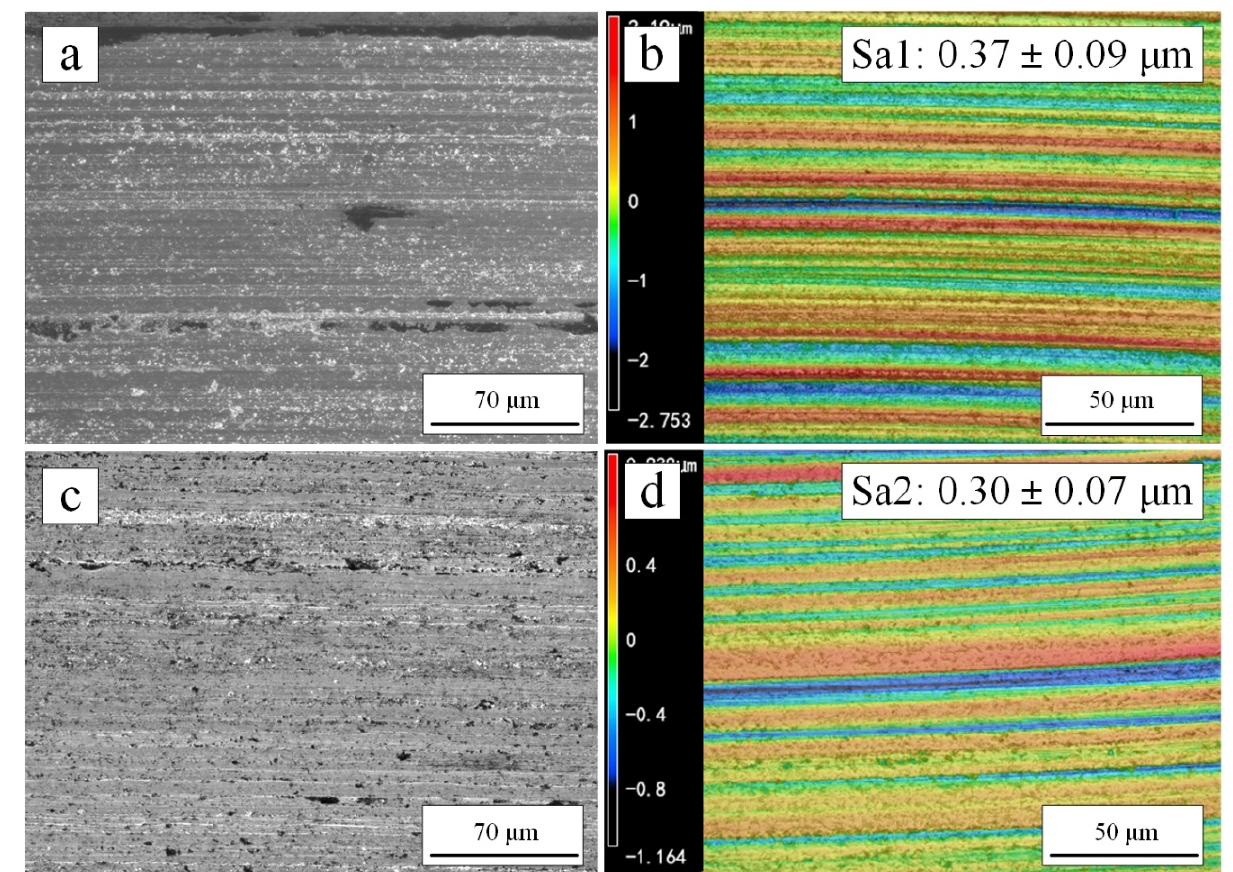
Figure 12. SEM images ( a , c ) and 3D profiles ( b , d ) on the worn surfaces of a cemented carbide ball after a tribology test: ( a , b ) corresponding to as-sprayed coating; ( c , d ) corresponding to 500 °C heat-treated coating.